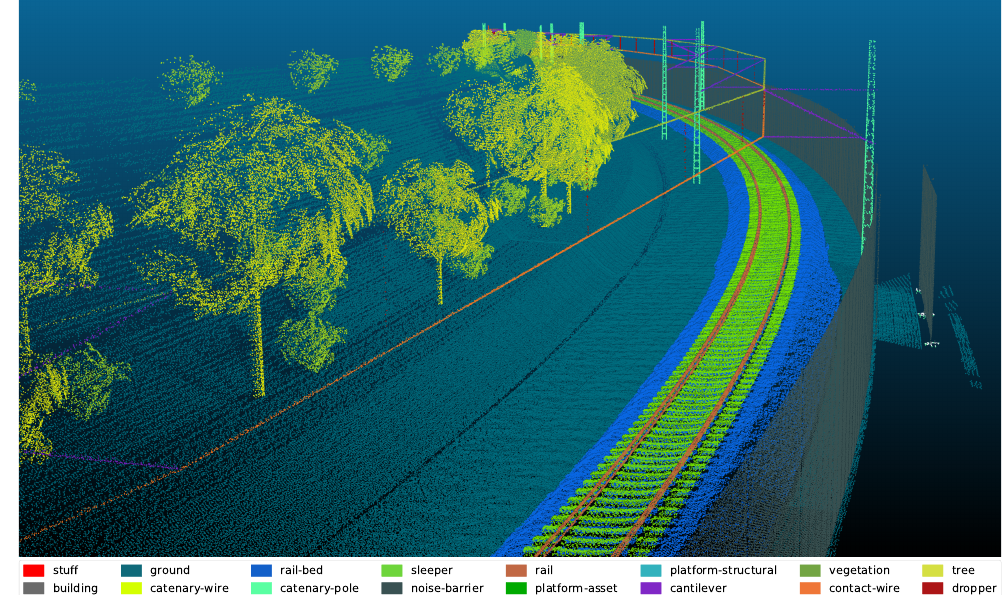
Figure 3. Example of the synthetic data generated from a 3D CAD Model. The simulation includes typical systematic and random noise and adheres to the chosen